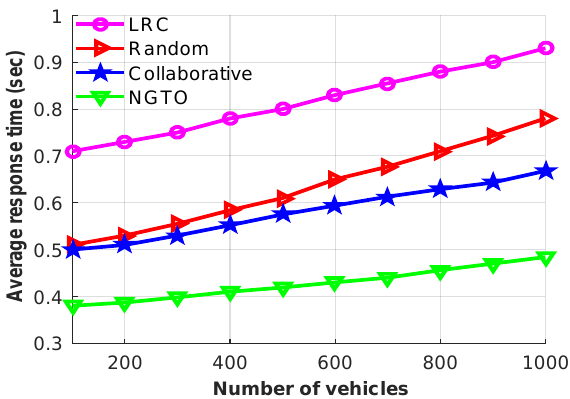
Figure 4. The average response time based on the number of